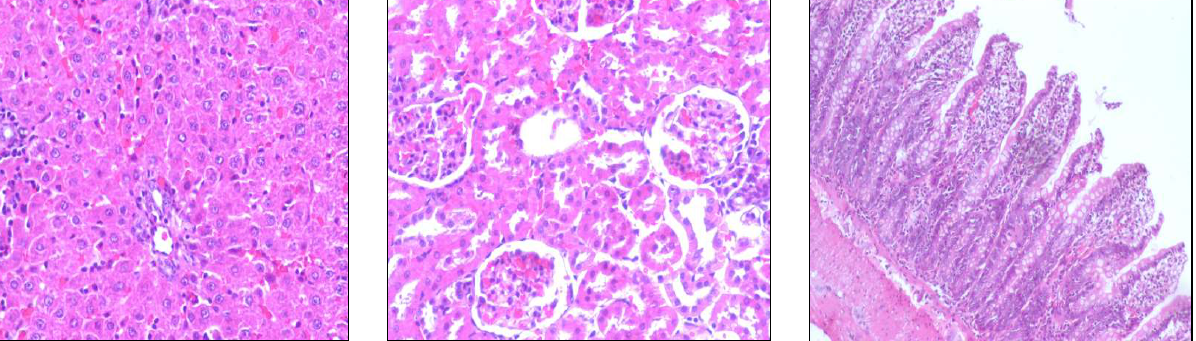
Figure-1 . Histopathology image of liver from Group IV rat showing swollen and granular hepatocytes, congestion, prominent biliary hyperplasia in periportal region in repeated 28 day toxicity study by H and E stain (200 X).